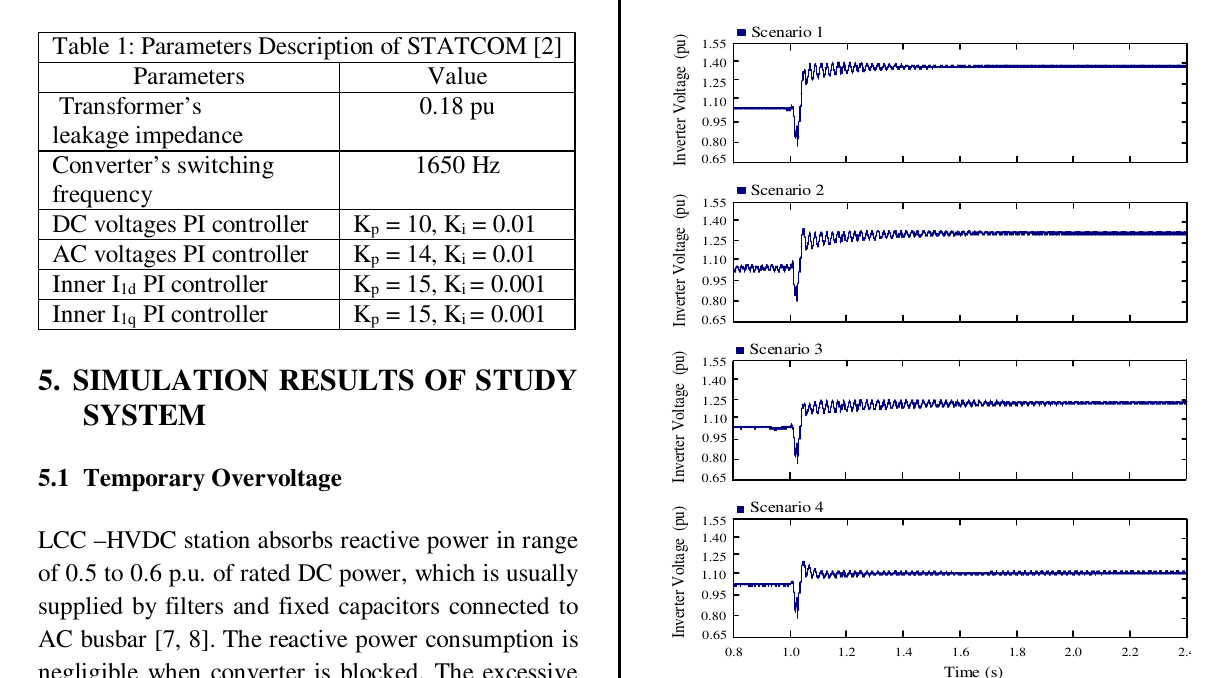
Fig.4: Temporary Overvoltage during Permanent DC